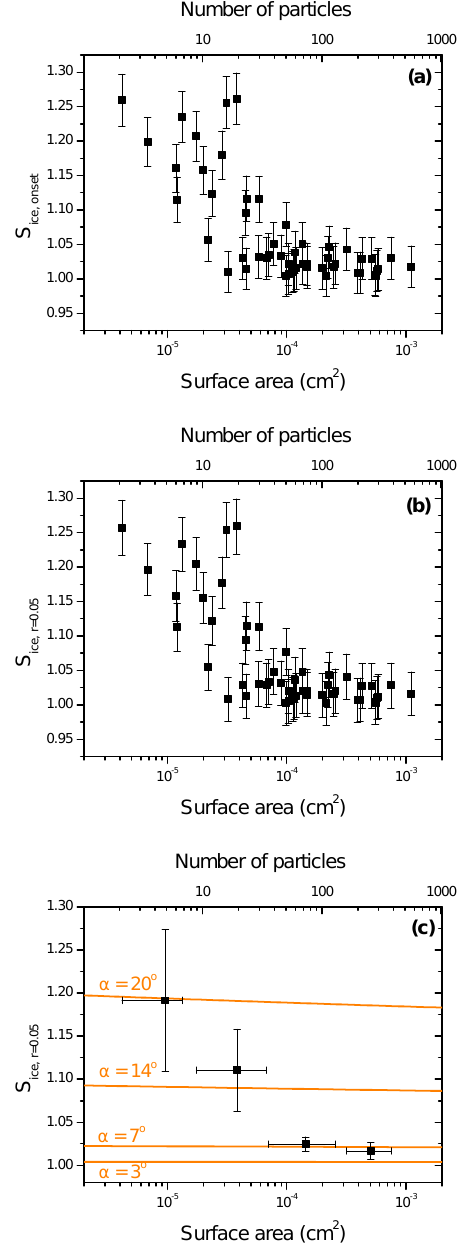
Fig. 5. Results for illite particles: (a) individual onset measure- ments, (b) individual S ice ,r = 0 . 05 results and (c) average S ice ,r = 0 . 05 . The average values are calculated for four equally sized bins and the horizontal error bars show the range of data points in each bin. The surface area values in (c) represent the average surface area of the points in each bin. Error in S ice , onset is given as experimental er- ror in measurements of saturation. Error in S ice ,r = 0 . 05 is based on the difference between S ice , onset and S ice , previous as well as the un- certainty in measuring S ice , onset . Error in the average S ice ,r = 0 . 05 represents the 95% confidence interval. Predictions are shown us- ing the single- α model (orange lines) calculated using Eq. (9). In addition to surface area, the corresponding number of particles cal- culated from A average is also